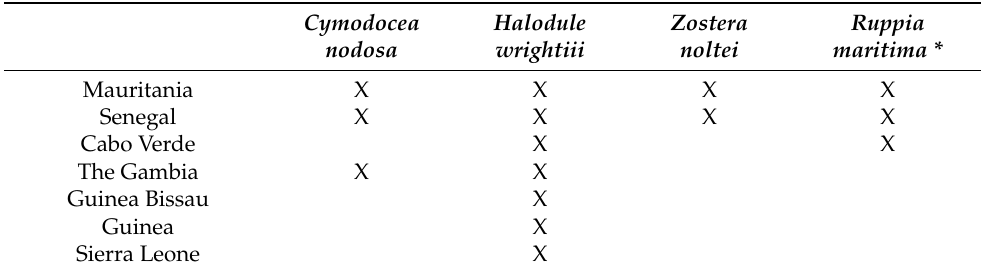
Table 2. Seagrass species occurrence across the studied West Africa region. * Information drawn from previous studies [32–34]. Cymodocea Halodule Zostera Ruppia nodosa wrightiii noltei maritima * Mauritania X X X X Senegal X X X X Cabo Verde X X The Gambia X X Guinea Bissau X Guinea X Sierra Leone